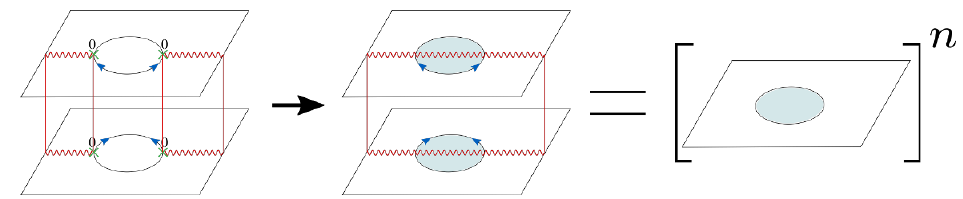
Figure 15 . The computation of the entropy of the entire (cid:13)at space regions including the boundary points. The dominant gravitational saddle connects consecutive sheets. This factorizes into n separate sheets and produces a vanishing entropy consistent with the purity of the (cid:13)at space region union the endpoints. The blue arrows indicate how the unit circle is identi(cid:12)ed across the cut. to the action of certain cosmic branes which are manifestly very light in the n ! 1